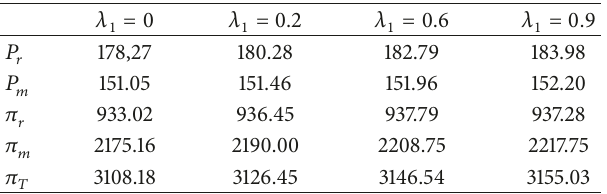
Table 1: The prices and profits with different level fairness concerns of retailer when 𝜇 = 0.6, 𝜆 2 = 0.2 .